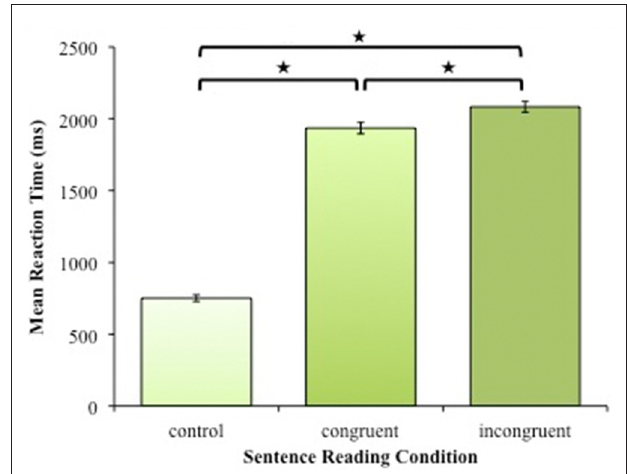
FIGURE 5 | Reaction times per condition during the sentence reading fMRI task. The means are averaged across participants, the error bars represent the standard error of the mean. All means were significantly different from each other as indicated by an “ ∗